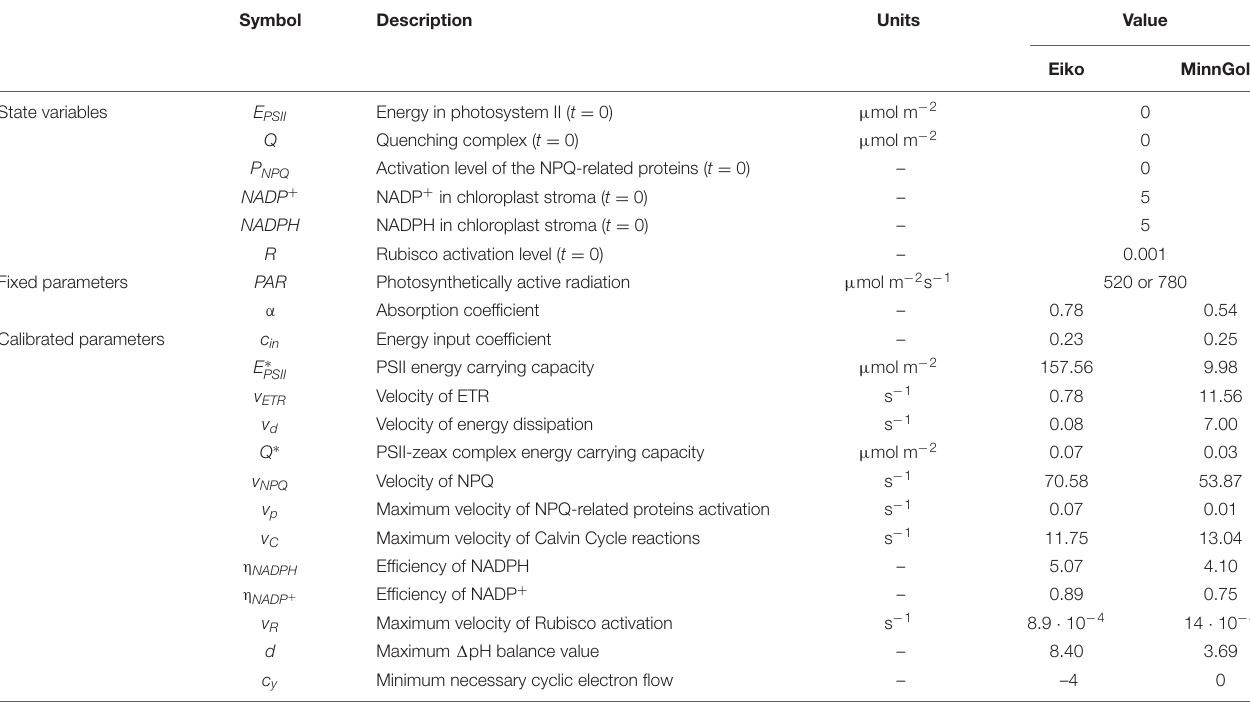
TABLE 1 | State variables, fixed parameters, and calibrated parameters of the